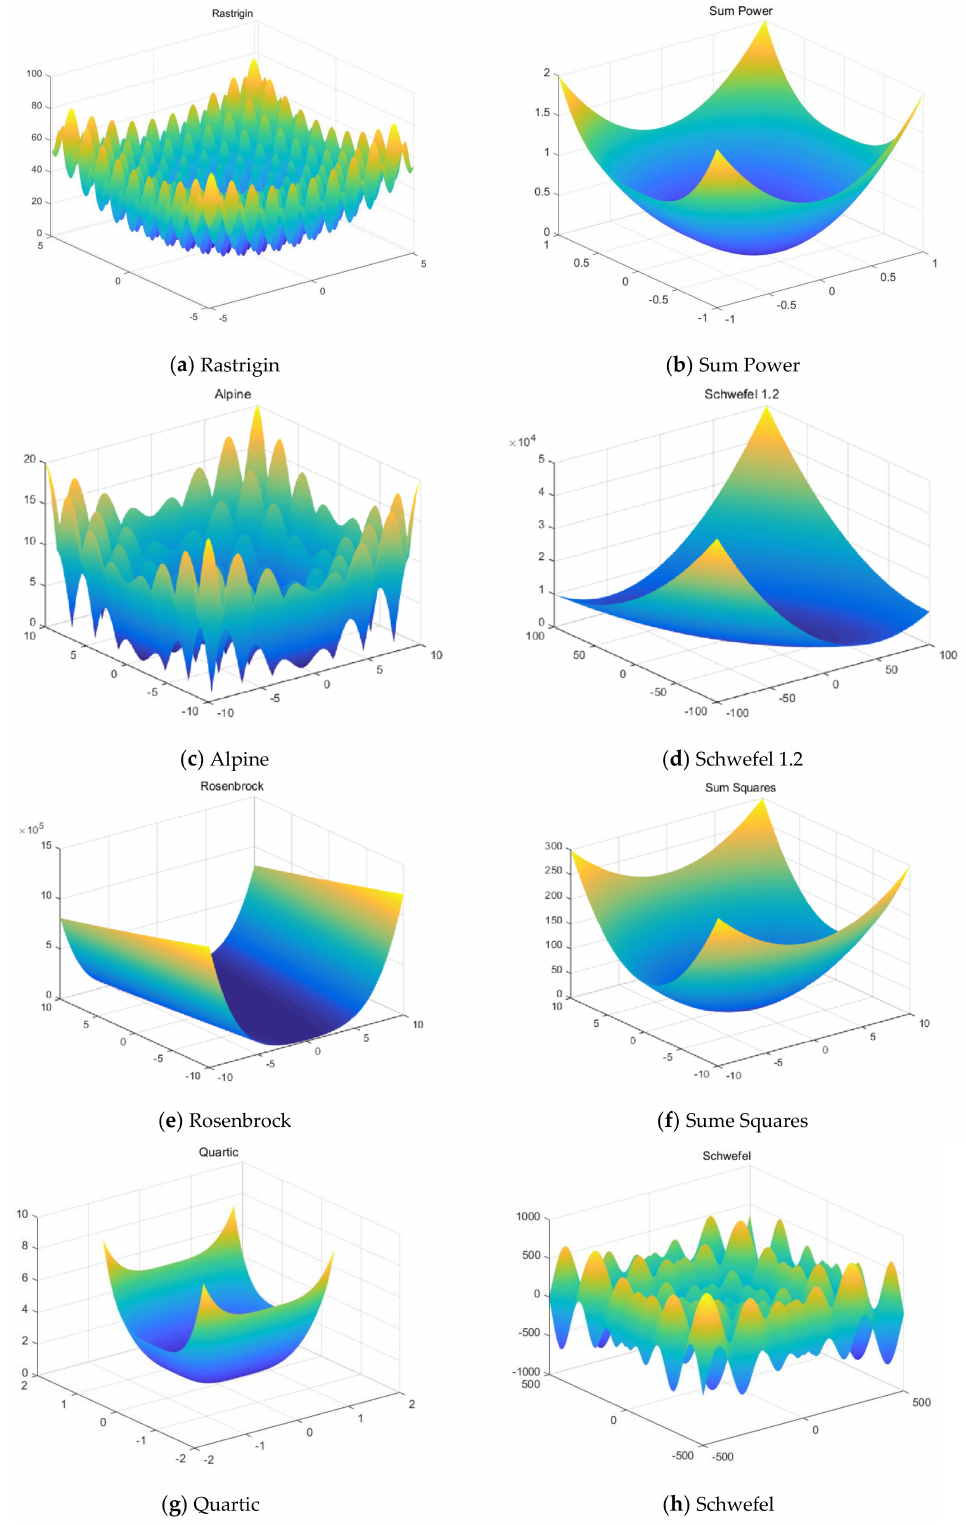
Figure 4. Eight numerical benchmark functions for D =